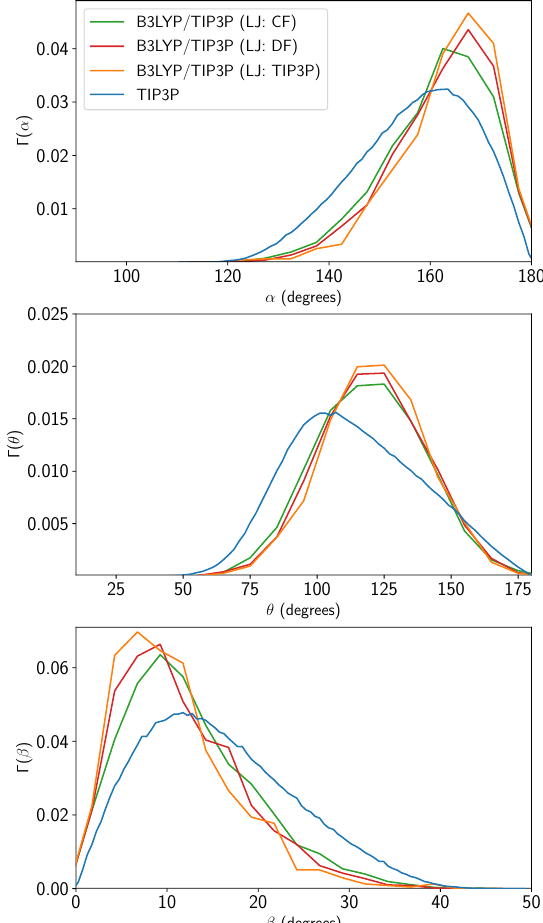
Figure A4. QM / MM and pure MM angular distribution functions. See Figure 1 for definitions. The α and β angles are most a ff ected by the change of QM / MM LJ parameters to the CF set, whereas the DF parameters provide angular orientations that are similar to the structure from the TIP3P